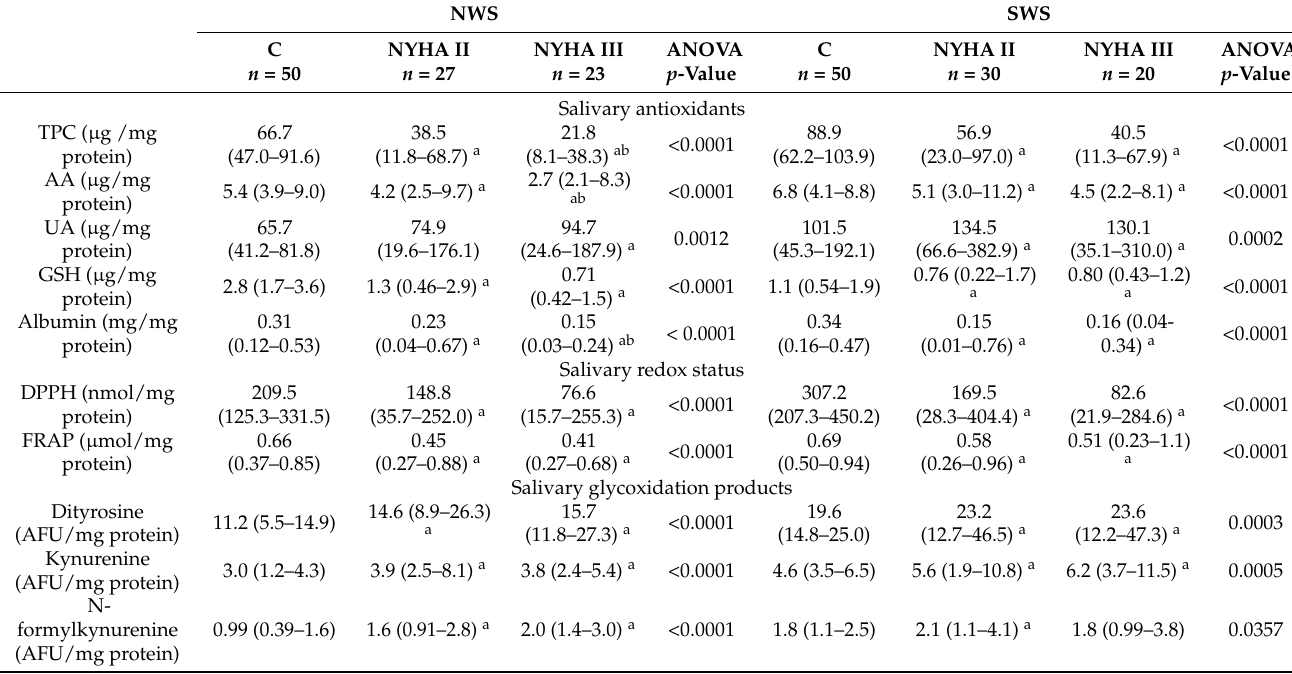
Table 4. Comparison of salivary redox biomarkers in NYHA class II, as well as NYHA class III, HF patients and the control